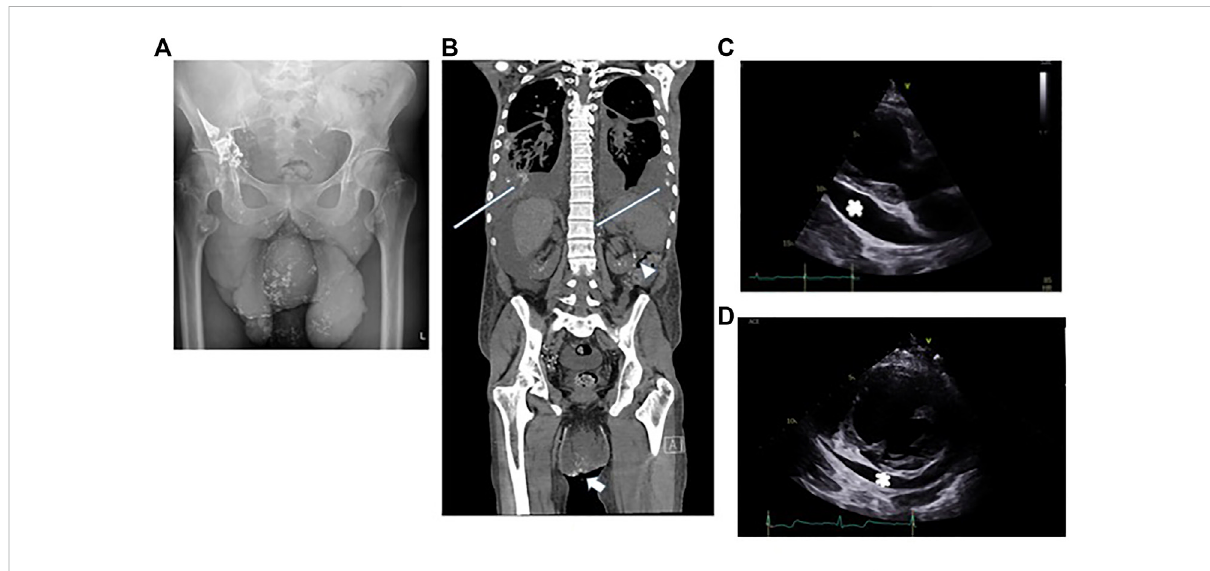
FIGURE 4 Patient B: (A) Re fl ux of contrast into the penoscrotal mass from the right inguinal lymphatics. (B) Non contrast CT showing bilateral pleural effusions, ascitesandthepenoscrotalmass.Long white arrows showresiduallipiodolleakageintothepleural effusions bilaterally.Arrowheadshows lipiodol in the small bowel mesentery. Short white arrow shows lipiodol re fl ux into the scrotum. (C) Echocardiogram, 2 months after pericardiocentesis-parasternallongaxisviewshowingalarge > 2 cmpericardialeffusion(whiteasterix)adjacenttotheleftventricularposterior wall. (D) Echocardiogram, 4 months after commencing treatment with trametinib parasternal short axis view con fi rming reduction in pericardial effusion size around the left ventricle (marked with a white